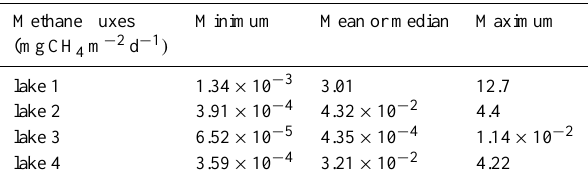
Table 1. Bounds for methane fluxes released by the winter lake ice cover. The median value is used if the mean value is higher than the standard